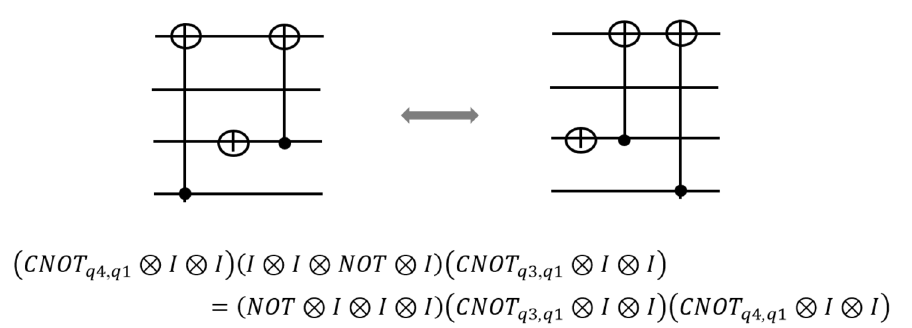
Figure 4. A quantum circuit and its